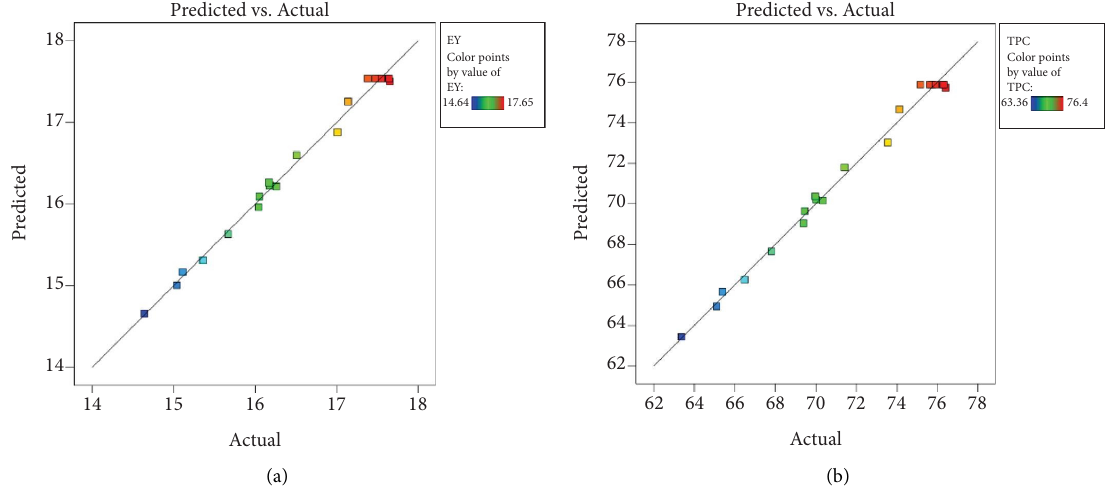
Figure 3: Linear regression plots of the predicted and experimental values for extraction yield (a) and total phenol content